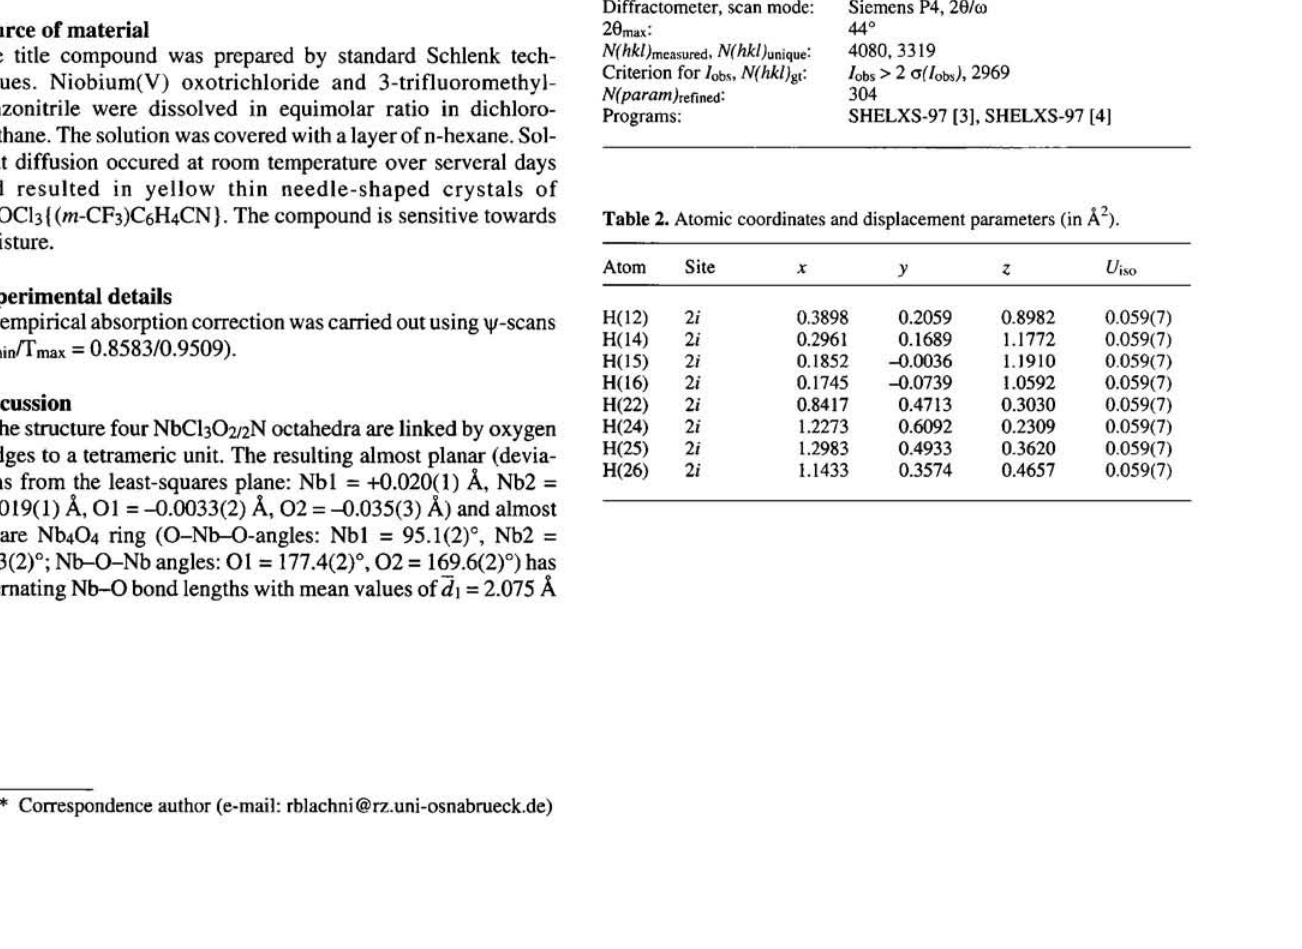
Table 1. Data collection and handling.